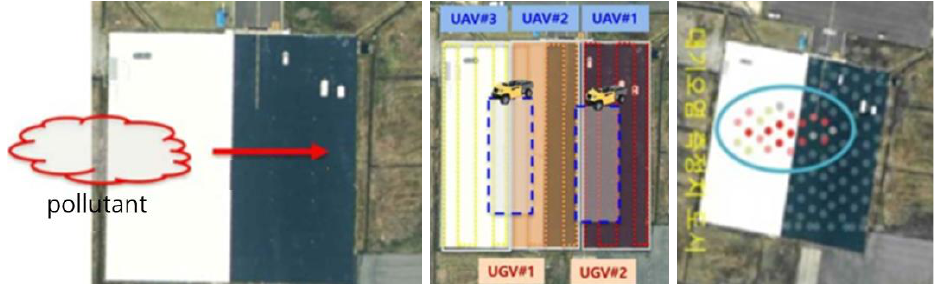
Figure 14. Air pollution mapping scenario using multiple unmanned vehicles [26]: a mission to quickly create an air pollution map with a number of unmanned vehicles in order to identify the state of air pollution occurring in a specific area. UAVs #1, #2, and #3 make a map while flying in a zigzag area divided into certain regions. UGVs #1 and #2 draw a map while circling the assigned area divided into certain regions.